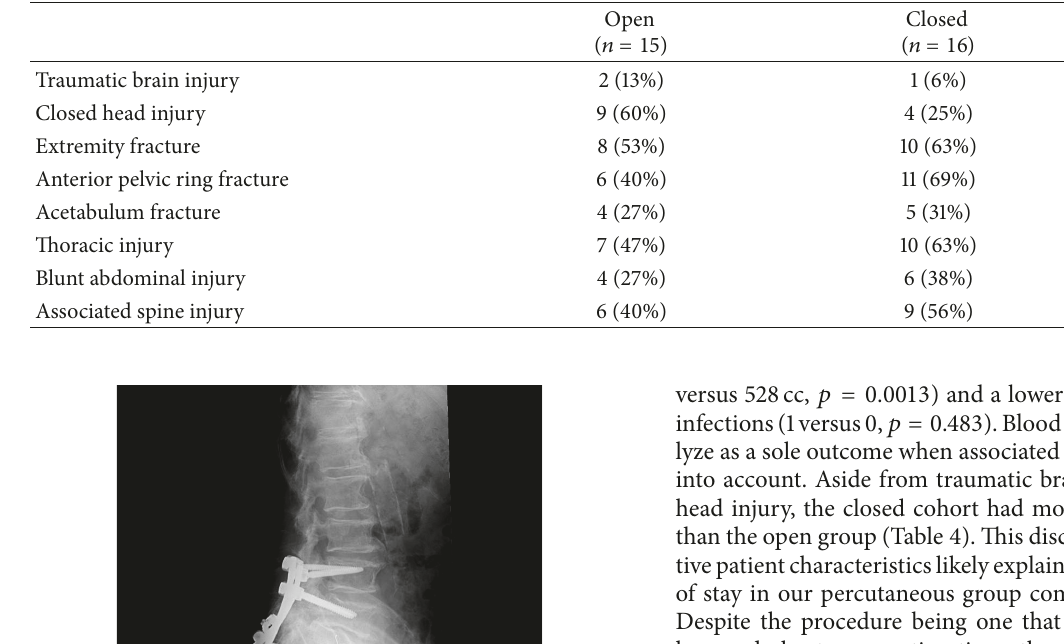
Table 3: Associated traumatic injuries.